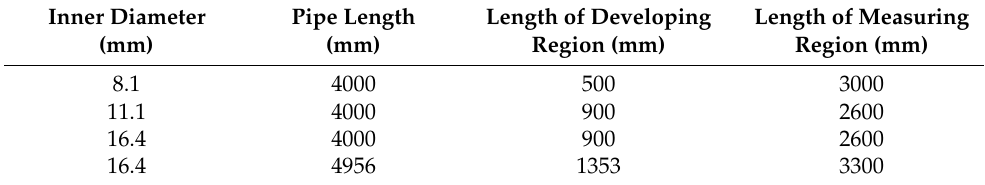
Figure 1. Experimental apparatus working in the temperature range from 20 to 45 °C ( a ) and from 0 to 20 °C ( b ).